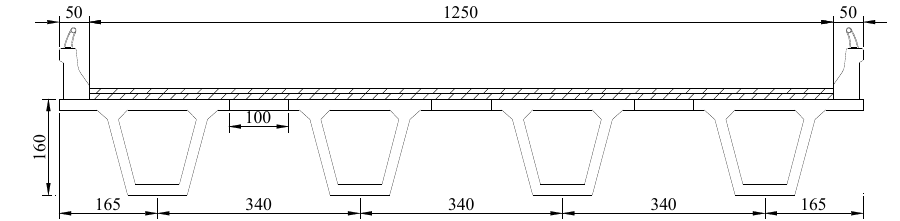
Figure 8. Cross-section of the precast concrete continuous box-gird bridge (unit: cm).